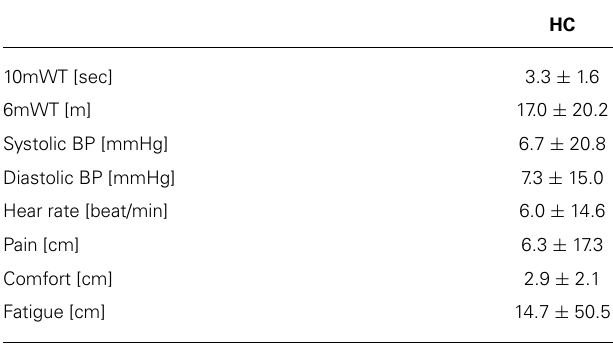
Table 2 | Summary of evaluation results: 10mWT and 6mWT tests and subjective